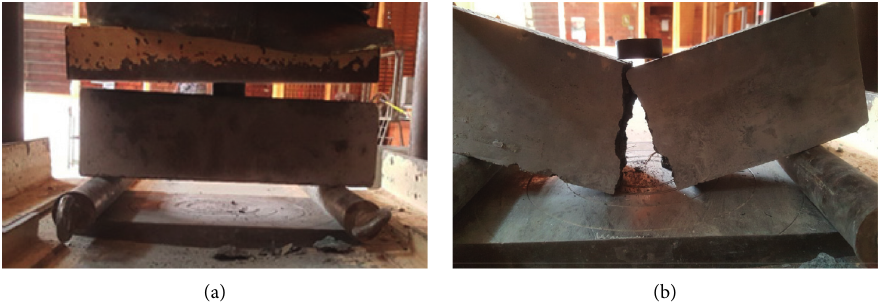
Figure 6: Flexural strength testing. (a) Flexural strength test setup. (b) Failure mode of concrete under